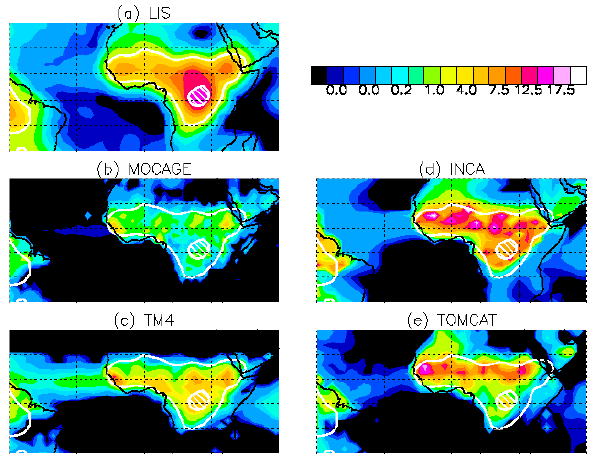
Fig. 10. August 2006 latitude-pressure cross-sections averaged over 0 ◦ –30 ◦ E of O 3 difference between LiNO x -off and Conv-off simu- lations by (a) MOCAGE (b) TM4 (c) INCA and (d) p-TOMCAT.